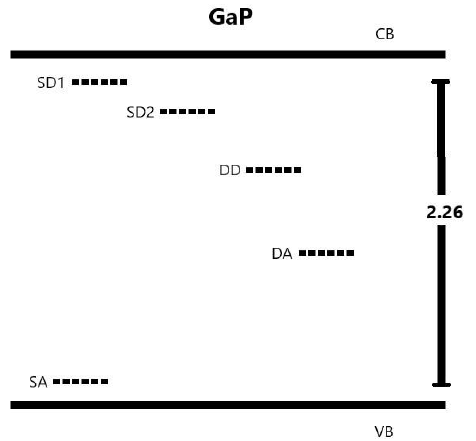
Figure 1. The energy model of the material structure adopted during the simulation. The designations CB and VB denote the conductivity and valence bands, respectively. The defect symbols SD1, SD2, DD, DA, and SA denote in order two shallow donor defects, one deep donor, one deep acceptor, and one shallow acceptor.